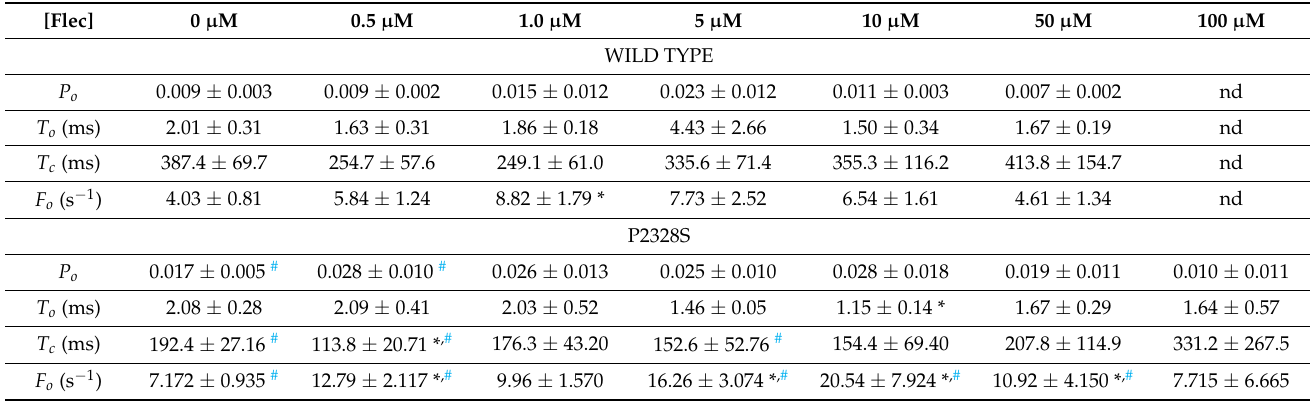
Table 2. Gating parameters for high or activity wild type (WT) and P2328S RyR2 channels before and during flecainide exposure. Parameter values for wild type (WT) and P2328S channels before adding flecainide ([Flec] = 0 µ M) and with 0.5 µ M to 50 µ M (WT) or 100 µ M (P2328S) flecainide. 100 µ M flecainide not applied to WT channels (nd, not done). Mean ± SEM is presented. P o , open probability; T o , mean open time; T c , mean closed time; F o , frequency of opening.